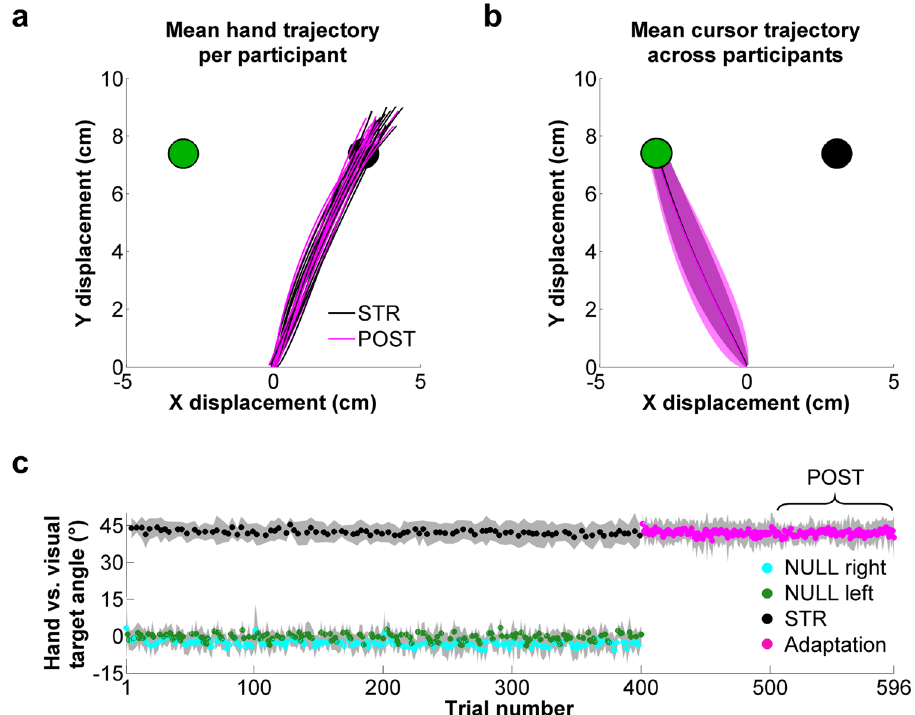
Figure 2. Reach trajectories and hand vs . visual target angle at peak velocity. ( a ) Mean hand trajectory for each participant and ( b ) mean cursor trajectory across participants during STR (black) and POST (magenta). ( c ) Hand vs . visual target angle at peak velocity throughout the experiment for NULL right (cyan), NULL left (green), STR (black) and adaptation (magenta)